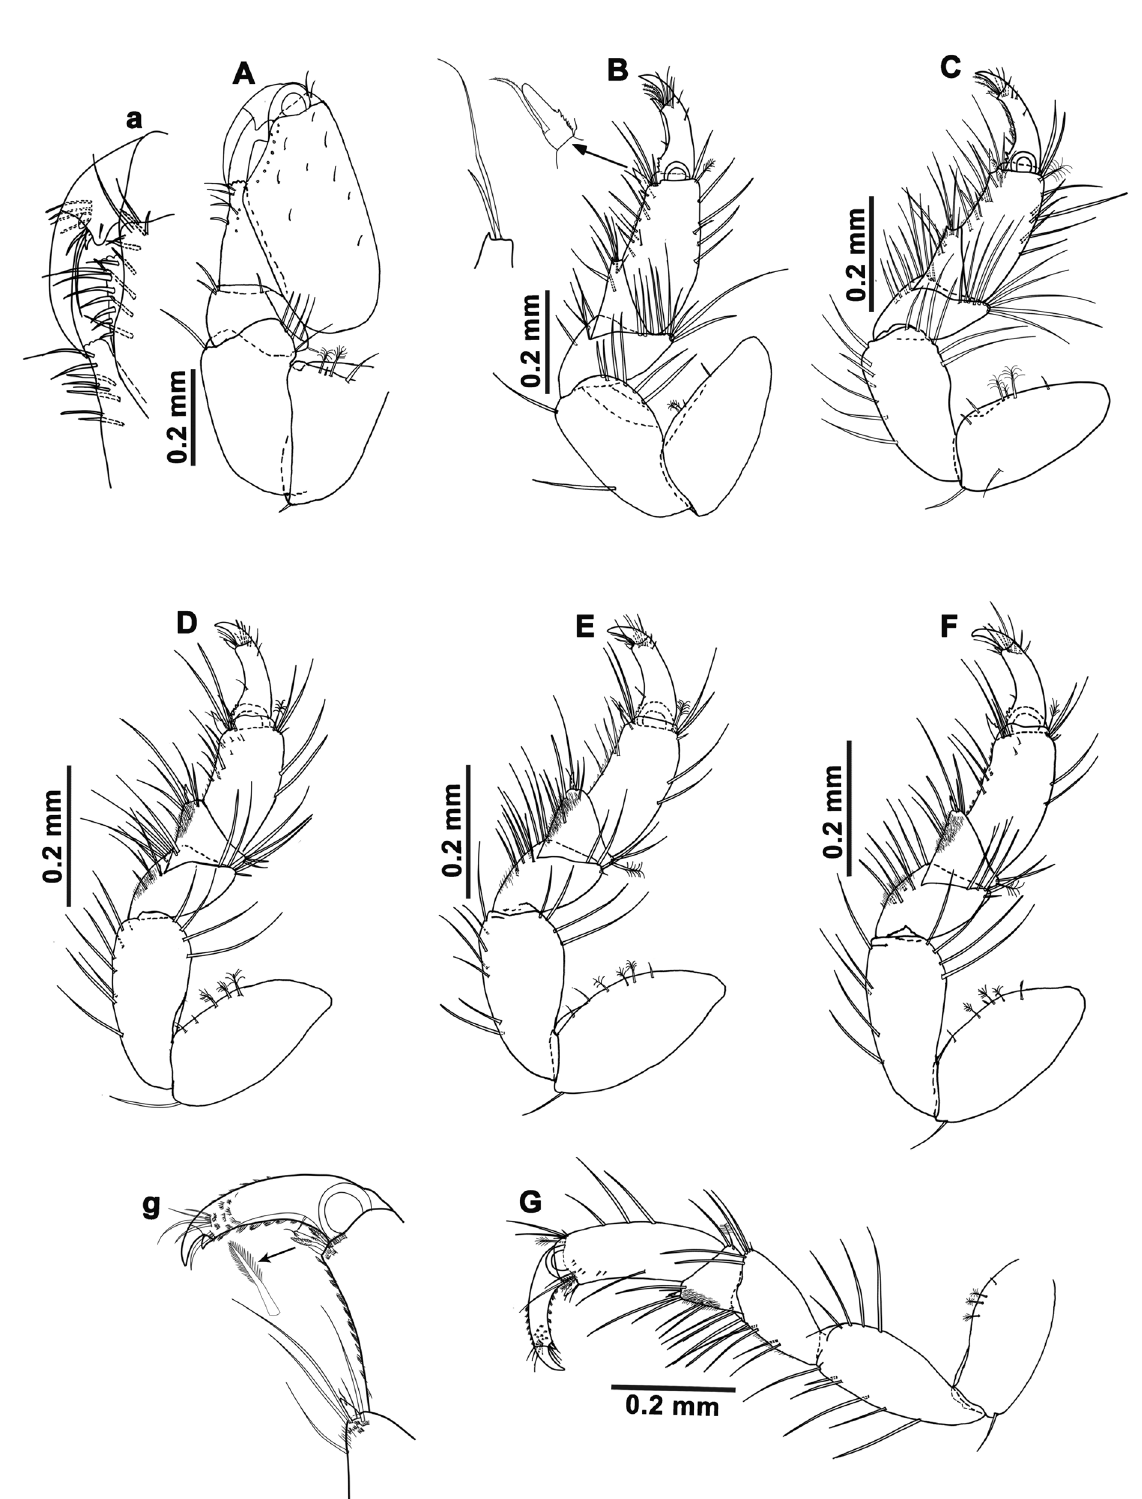
Fig. 3. Amakusanthura guerrerensis sp. nov., holotype, ♀, 5 mm, Guerrero, Ixtapa Island, Coral Beach (UMAR-PERA 522). A . Pereopod 1 and detail of the palm (a). B . Pereopod 2 and detail of the carpus and sensory spine. C . Pereopod 3. D . Pereopod 4. E . Pereopod 5. F . Pereopod 6. G . Pereopod 7 and detail of the propodus and dactylus